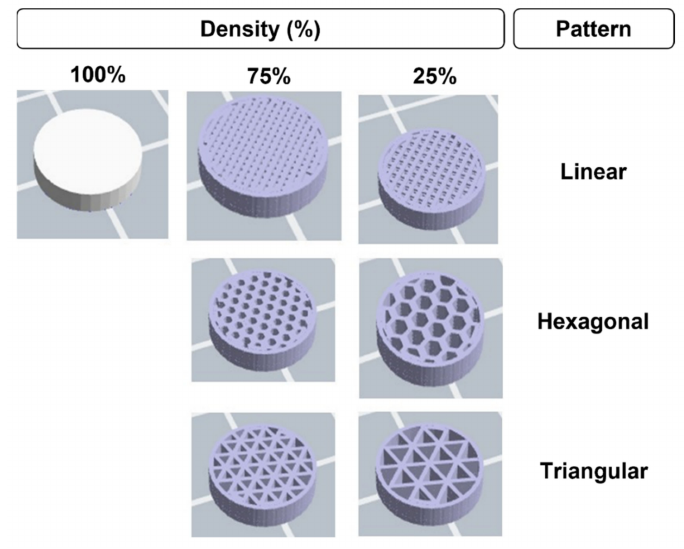
Figure 13. Examples of infill patterns and